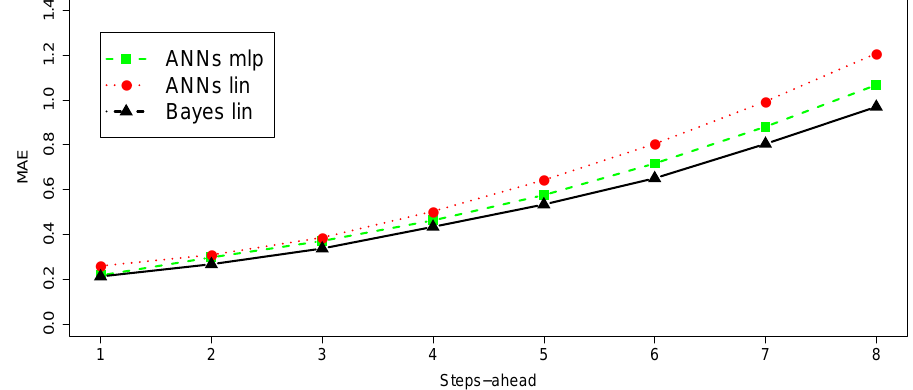
Figure 9. MAE of each step-ahead for last 15,000 for sin data.